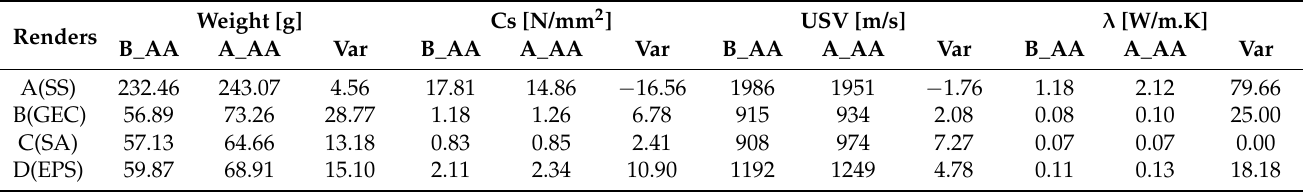
Table 4. Results from hygrothermal and IR accelerated agingf